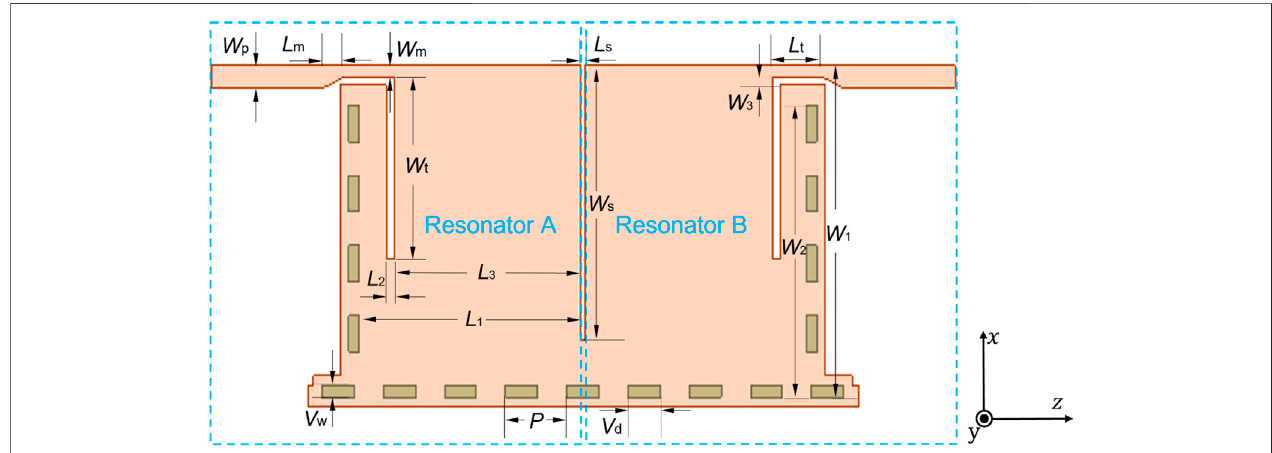
FIGURE 2 | Con fi guration of the proposed HMSIW BPF (Only top view of the TM1 layer is shown).